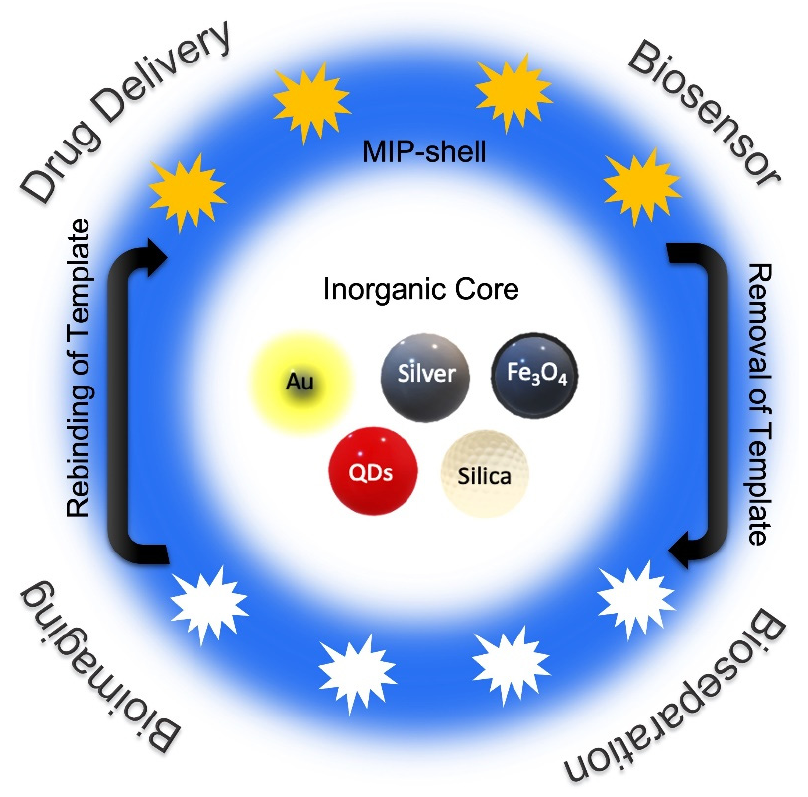
Figure 2. Illustration of various types of inorganic nanoparticles combined with MIP-shell and their possible biomedical applications.